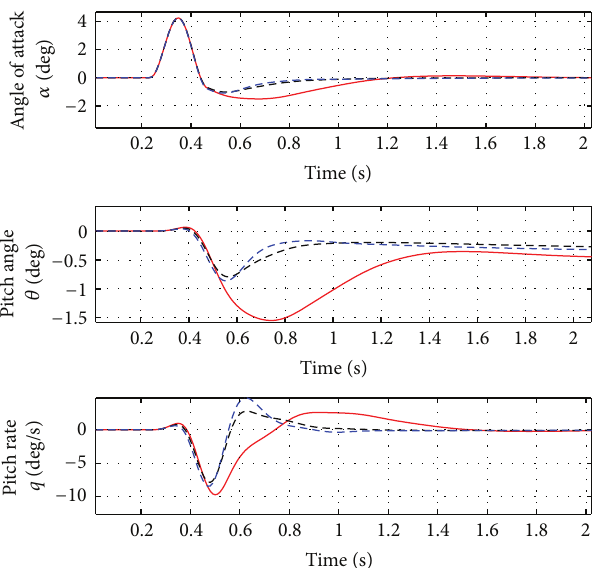
Figure 6: Rigid variable variation for nominal case with ideal and real actuator. Red solid line: open loop. Black dotted line: ideal actuator model. Blue dotted line: real actuator model.